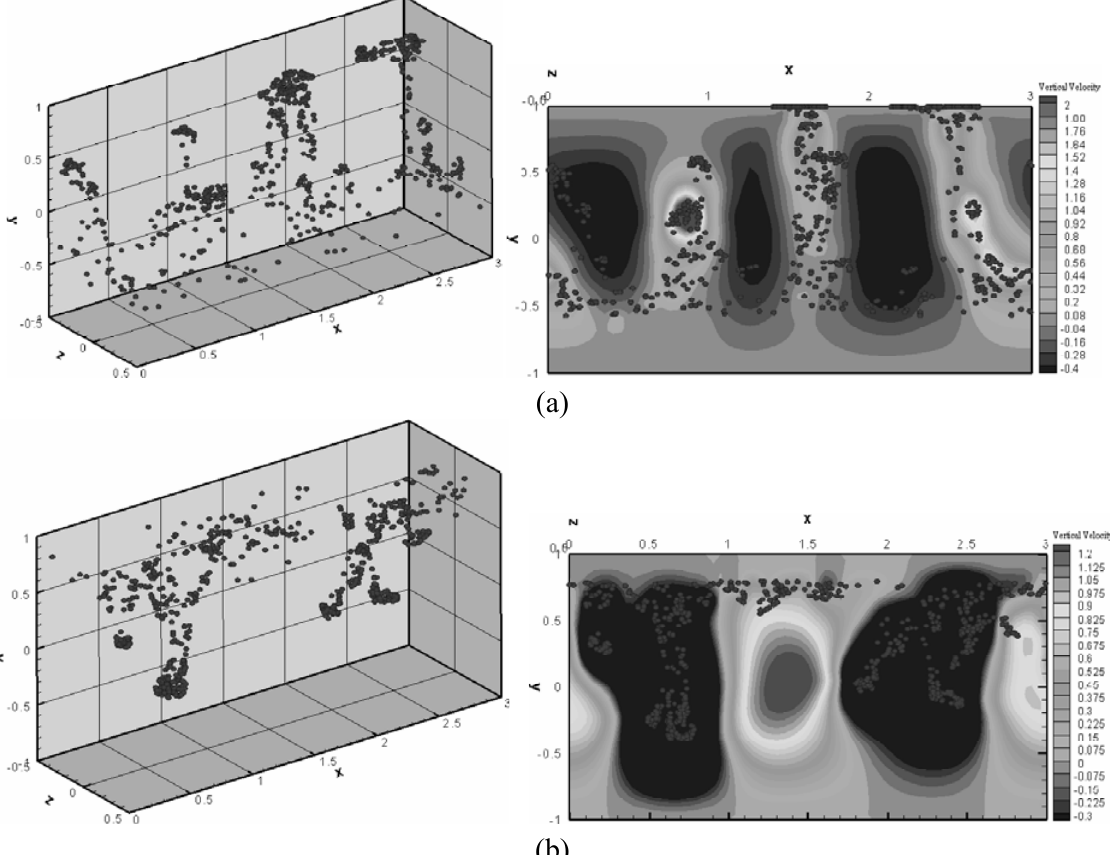
Figure 29. Distribution of magnetic particles (left) and the contours of the vertical velocity component (right) in a microchannel subjected to a time-varying magnetic field applied along the vertical direction; typical patterns during the (a) first half and (b) second half period (from Le et al.